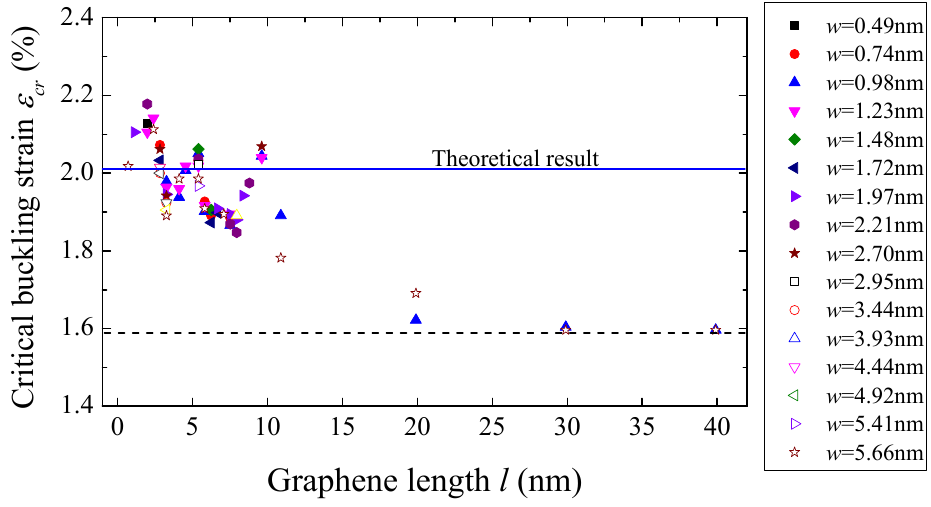
Figure 8. The critical buckling strain versus width of the monolayer graphene sheets with different sizes on a graphene substrate.